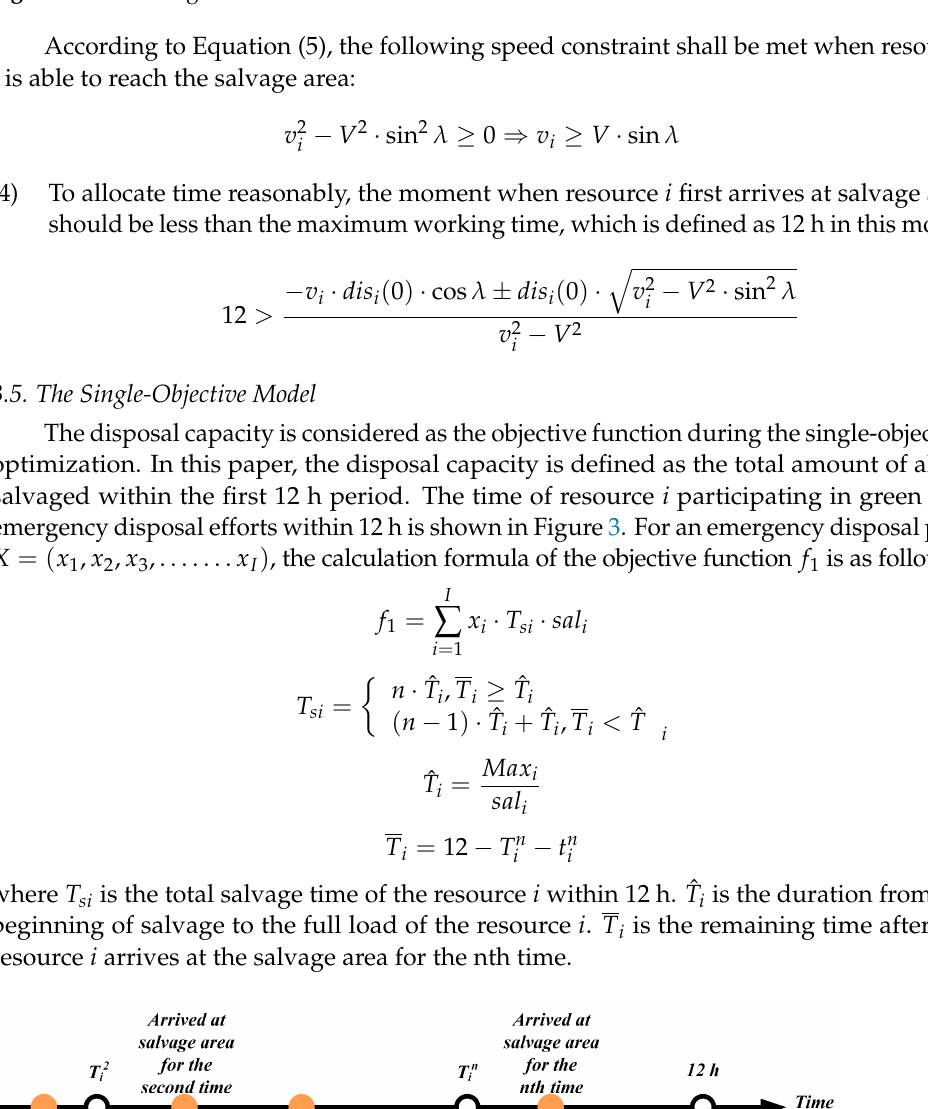
Figure 2. Stroke diagram of route.